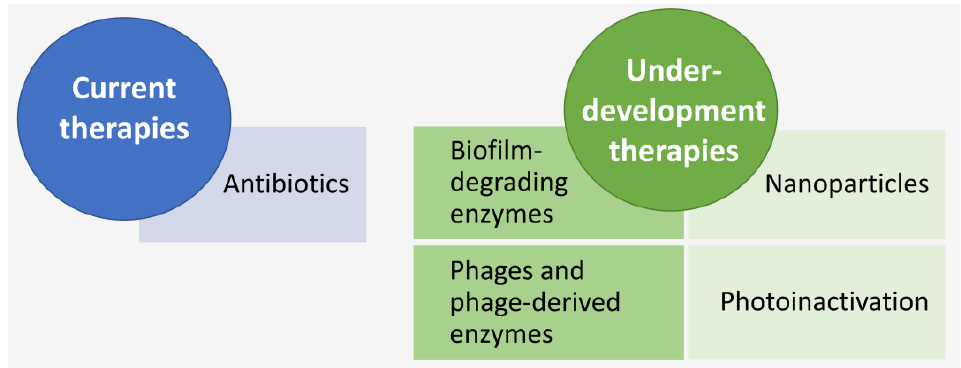
Figure 4. Summary of the current and under-development therapeutic methods for CoNS-associated infections, including LOS. The use of nanoparticles, as well as photoinactivation, which involves the use of visible light, a photosensitizer and oxygen to produce reactive oxygen species and free radicals that create oxidative stress in bacteria [158], have shown promising results in staphylococci biofilms, including methicillin-resistant S. aureus [268 – 270,276], but more studies are necessary to investigate their consequences on host cells.